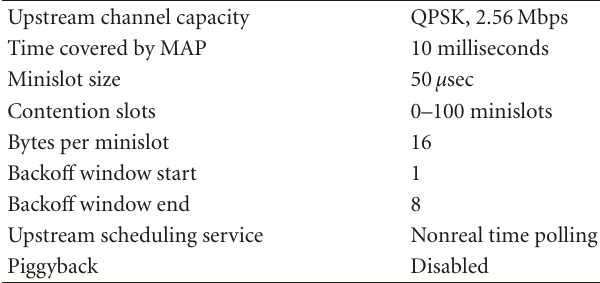
Table 1: The simulation